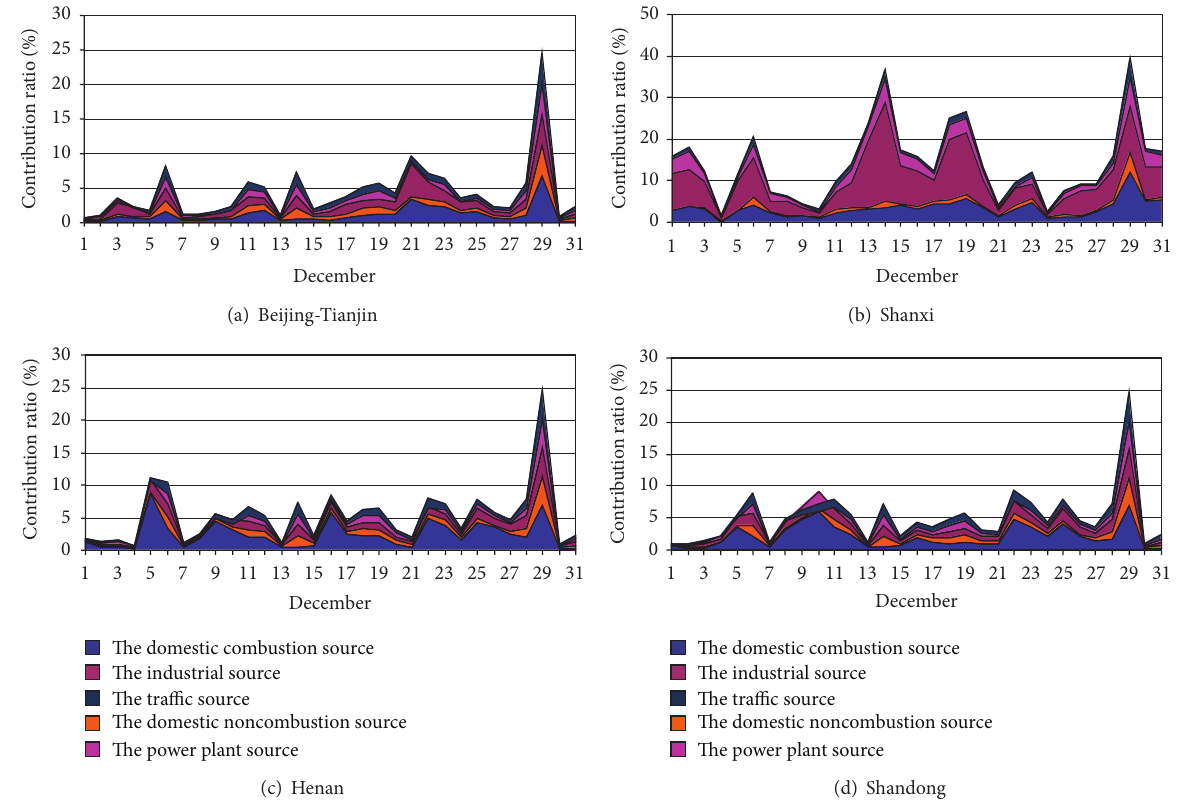
Figure 6: Contribution ratios of daily average PM 2.5 concentration from sector sources of the surrounding areas to Shijiazhuang in December